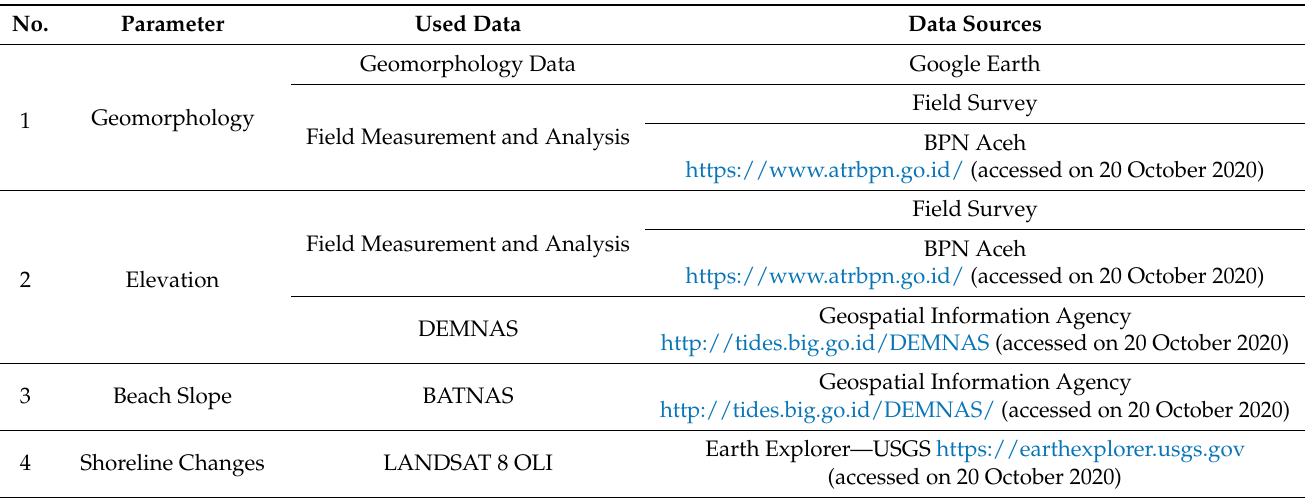
Table 1. Data acquisition for coastal